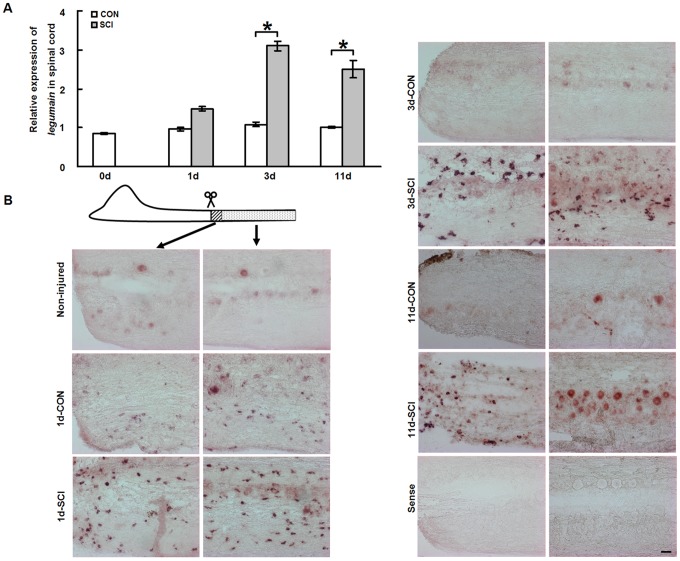

Legumain mRNA expression is upregulated in the caudal spinal cord after SCI.(A) Quantitative real-time PCR (qPCR) shows that legumain mRNA expression increases from 3 days post-injury and remains upregulated at 11 days after SCI. (B) In situ hybridization for legumain mRNA in the caudal spinal cord shows different expression patterns in the lesion site (area with stripes) and the caudal part of spinal cord (area with dots). In the non-injured spinal cord, legumain mRNA is only observed in neurons. In the lesion site, legumain mRNA is observed in many small cells at all time points tested after SCI. In the spinal cord caudal to the lesion site, legumain mRNA is detectable in small cells in both the sham-injured and SCI groups at 1 day, with a stronger signal for legumain mRNA after SCI compared to the sham injury group. At 3 days, while the signal for legumain mRNA in small cells is not detectable anymore in the sham-injured group, strong positive signal for legumain mRNA expression is observed in small cells in the SCI group. At 11 days, more positive neurons are seen after SCI compared to the sham-injury group. No signal is detectable with the sense probe. Rostral is left and caudal is right. A, n = 3 experiments; B, n = 4 fish for each group. * P<0.05, two-way ANOVA with Tukey's post hoc test; mean values ±SEM are shown. Scale bar, 50 µm.